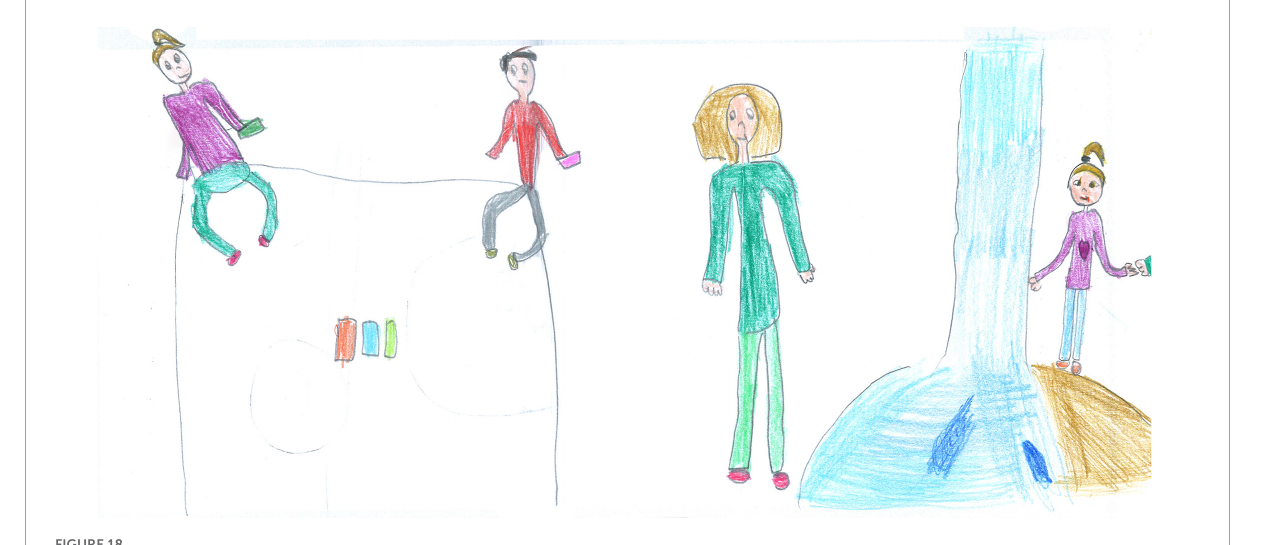
FIGURE18 PAIR’s shared neutrality (PS, Female, 10